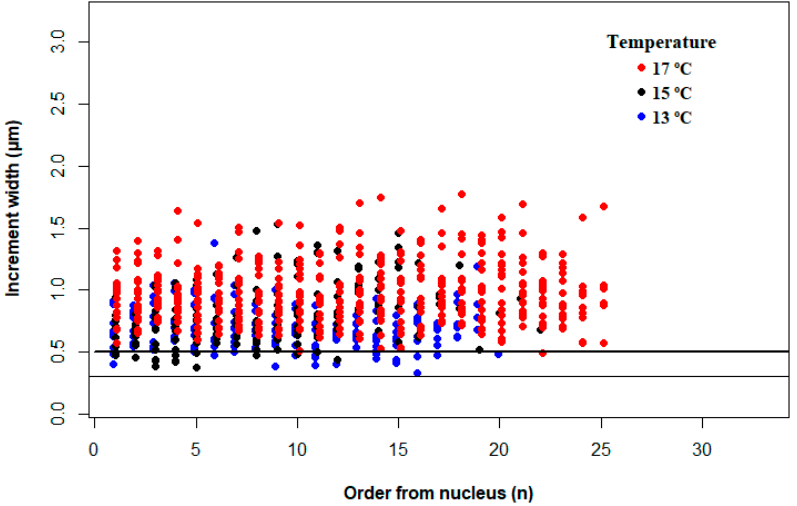
Figure 6. Relationship between otolith increment width and the order of the growth increment counted from the nucleus in otoliths of European sardine Sardina pilchardus (Walbaum, 1792) larvae reared at 13, 15, (black) and 17 °C (red). The horizontal lines represent the increments below 0.5 μ m width, which are hard to detect on most optical microscopes and the 0.3 μ m width, that represents the limit of the microscope used in this study.